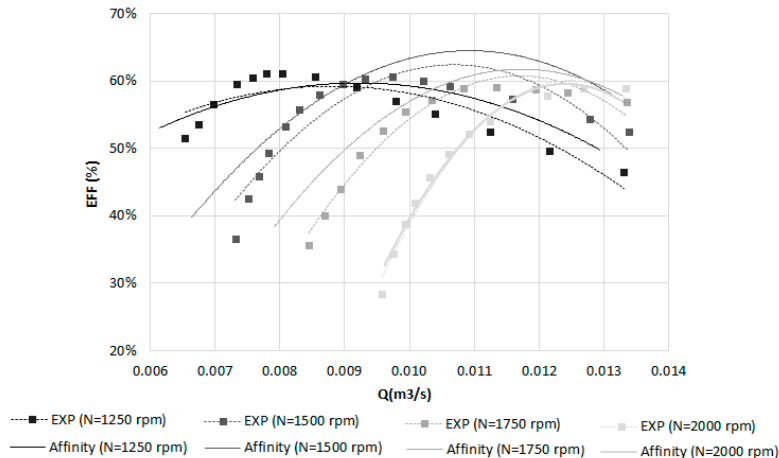
Energies 2019 , 12 , x FOR PEER REVIEW 10 of 16 Figure 8. Experimental and calculated e ffi ciency values by a ffi nity laws for D = 85 mm. Figure 8. Experimental and calculated efficiency values by affinity laws for D = 85 mm.